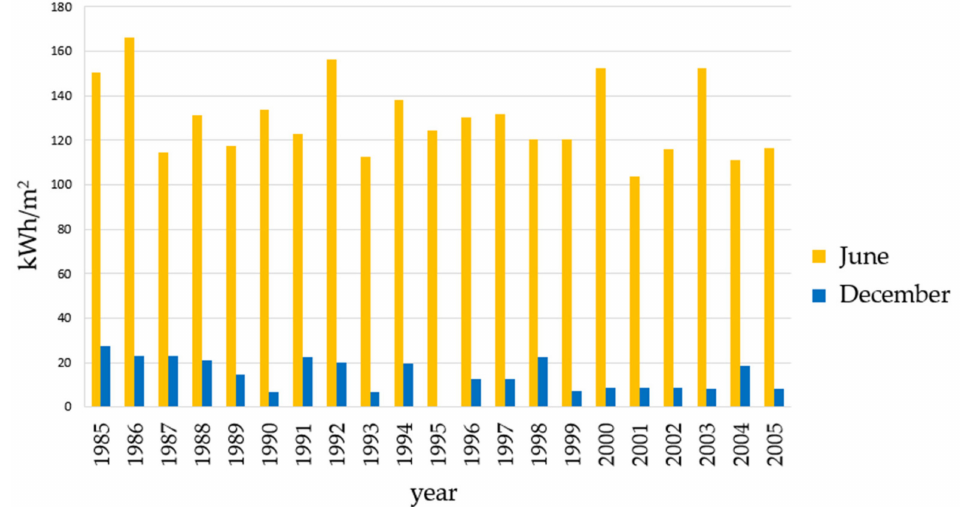
Figure 12. Average monthly daily solar radiation (kWh/m 2 ) for the centre of Warsaw in June and December (there are no data for December 1995) (Data source: